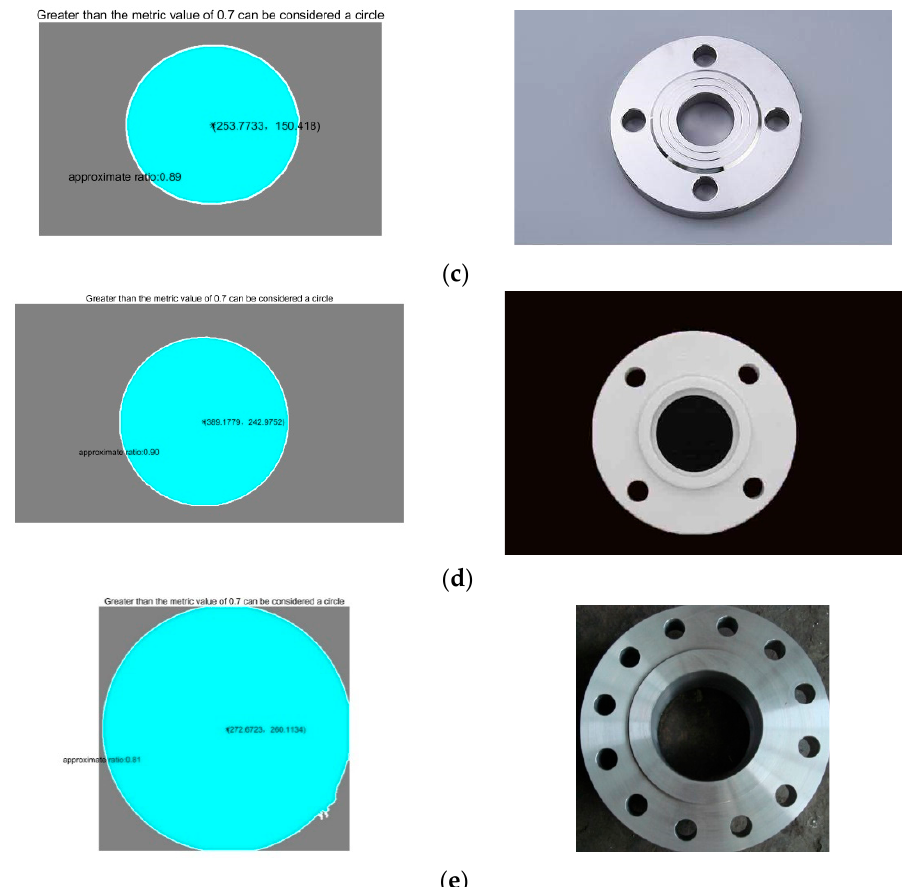
Figure 11. Flange end face physical detection experiment. ( a ) Represents the detection condition that is closest to the real working condition. ( b ) Represents the detection condition when the flange deviation angle is large. ( c ) Represents the detection condition with similar chromatic aberrations between the target flange and the background. ( d ) Represents the optimal working conditions. ( e ) Represents the detection of interference from ambient light to the flange surface.